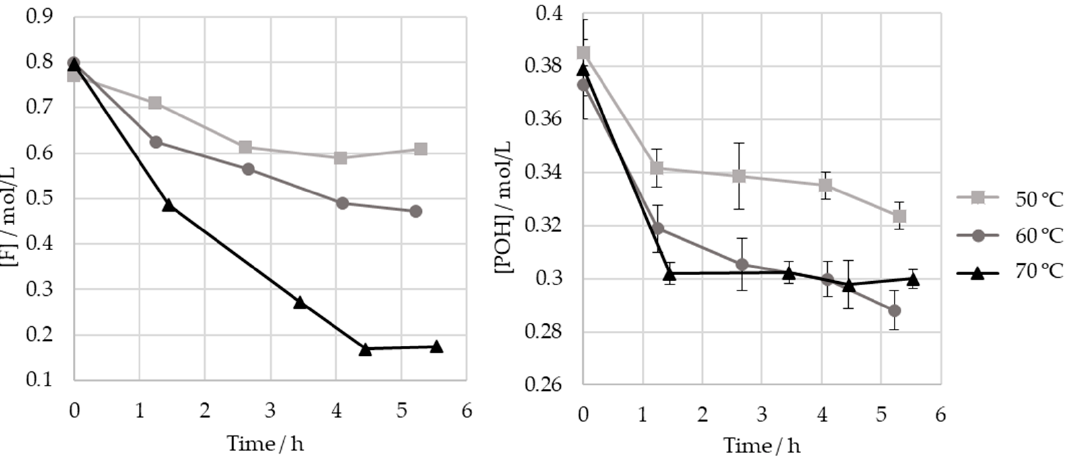
Figure 8. Consumption of formaldehyde and phenolic hydroxyl groups type I and II in the methylo- lation of HLS at 50, 60, and 70 °C. Table 5. Comparison between the consumption of formaldehyde and phenolic hydroxyl groups type I and II in the methylolation of HLS at 50, 60, and 70 °C.